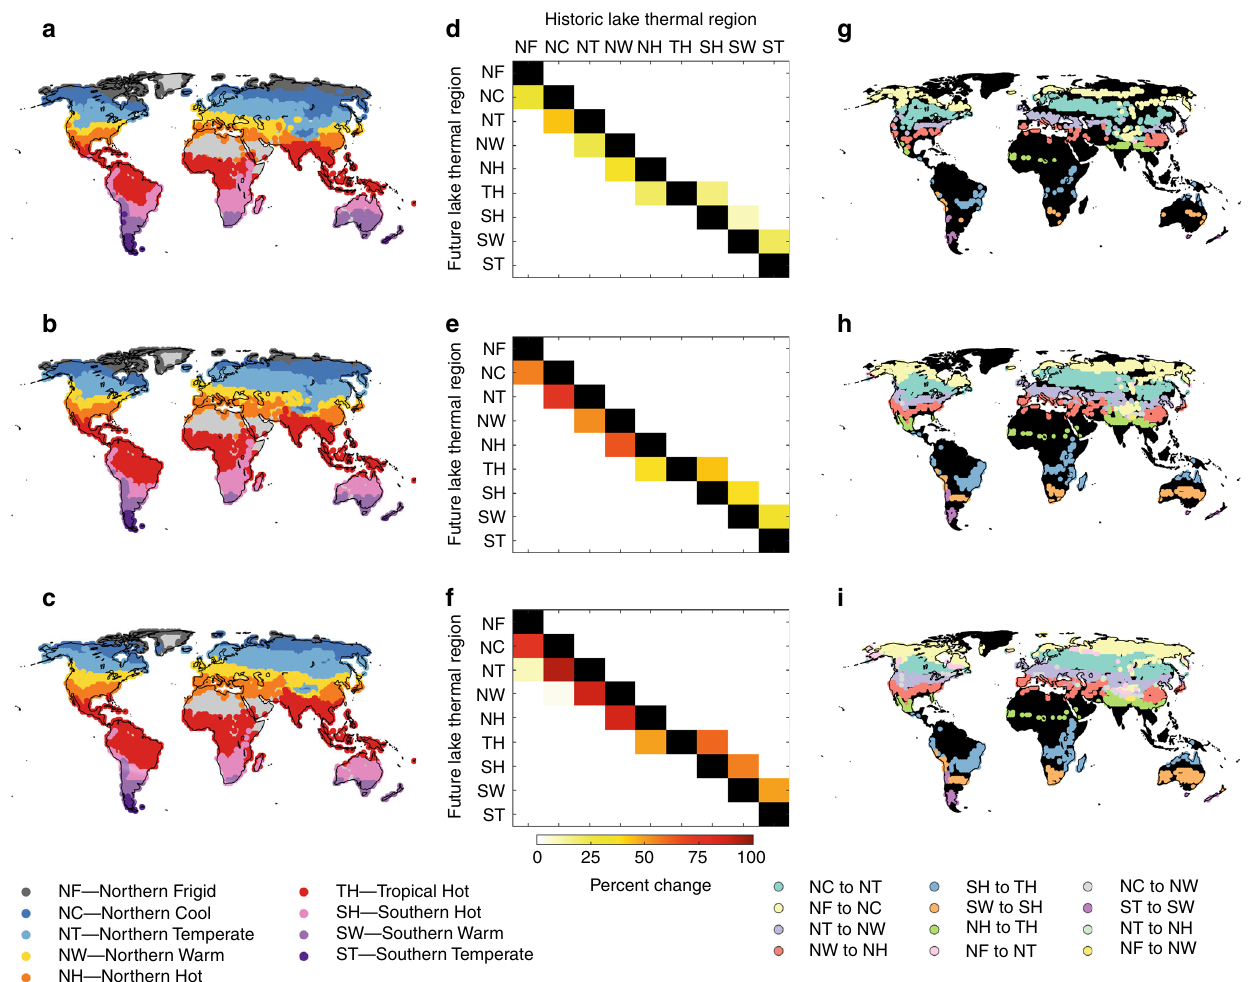
Fig. 4 Change in thermal region distribution for three climate scenarios. a , d , g RCP2.6; b , e , h RCP6.0; c , f , i RCP8.5. a – c show forecast distribution of lake thermal regions (grey represents areas without lakes); d – f show percent of lakes in each thermal region that will change by 2080 – 2099 compared to the historic period (1985 – 2005); g – i show lakes that will change thermal region compared to the historic period (black represents areas where no lakes have changed), the different changes in the legend are ordered by decreasing frequency of occurrence. All results, including those from the historic period, are produced using the bias-corrected HadGEM2-ES